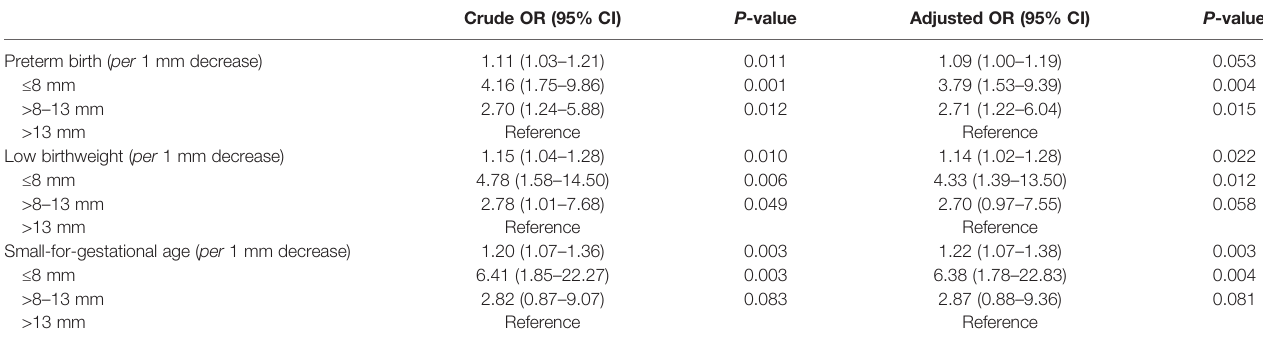
TABLE 4 | Crude and adjusted analyses of PTB, LBW and SGA based on endometrial thickness.